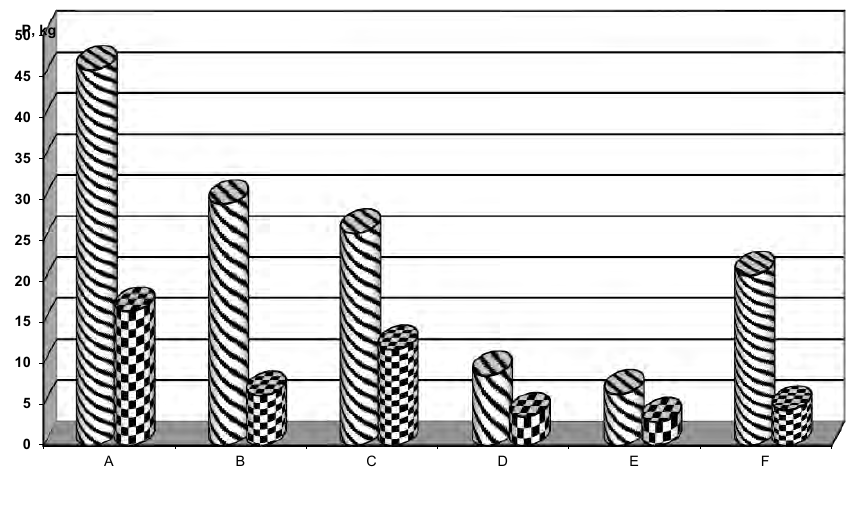
Fig.2. Dynamic of changes in special physical fitness (SPF) in control and experimental groups in competition period: P – Indicators; A – Squatting with barbell; B – Barbell pressing in lying position; C – back strength; D – barbell pressing in standing position; E – arms’ bending in standing position; F – barbell pressing with narrow grasp, in lying